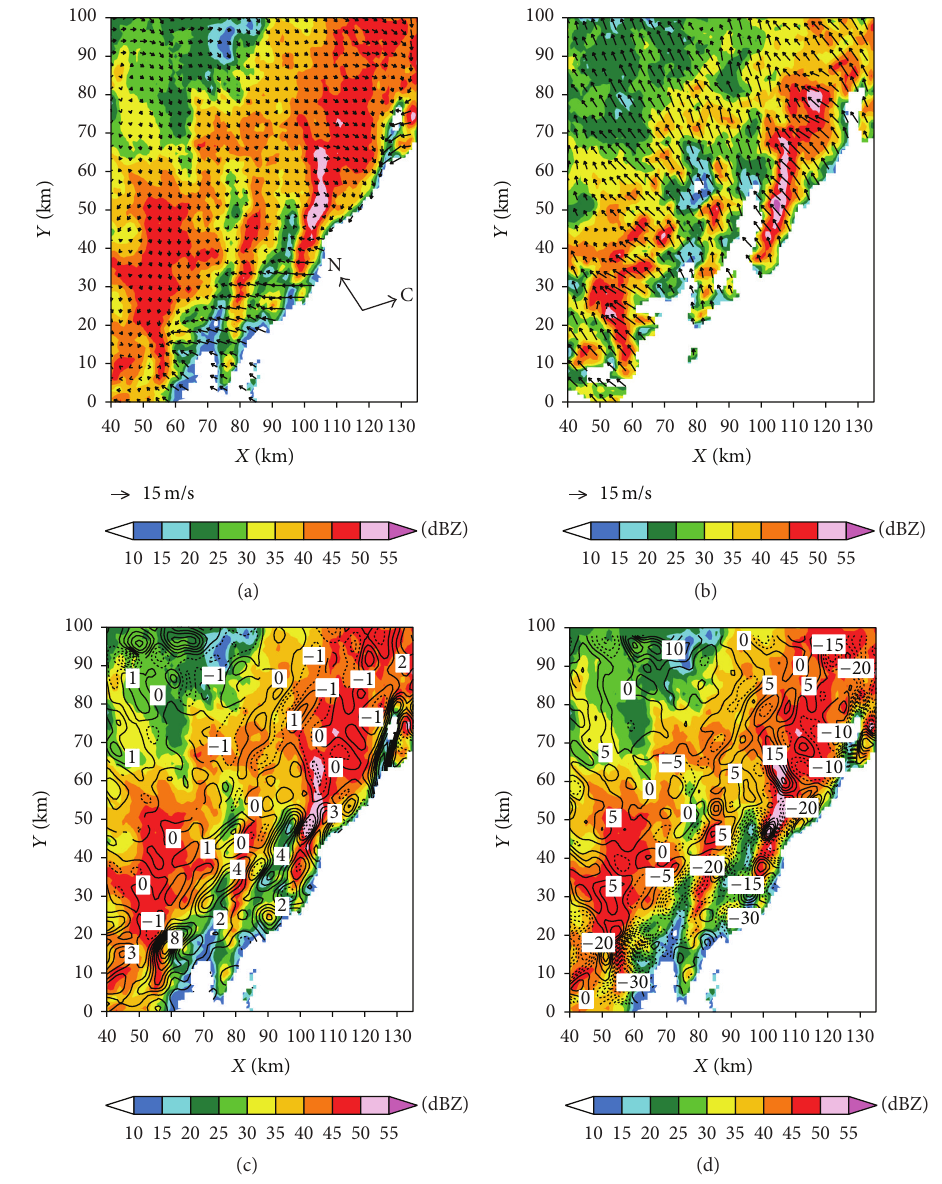
Figure 12: The same as Figure 11, except at 1041LST 24 April